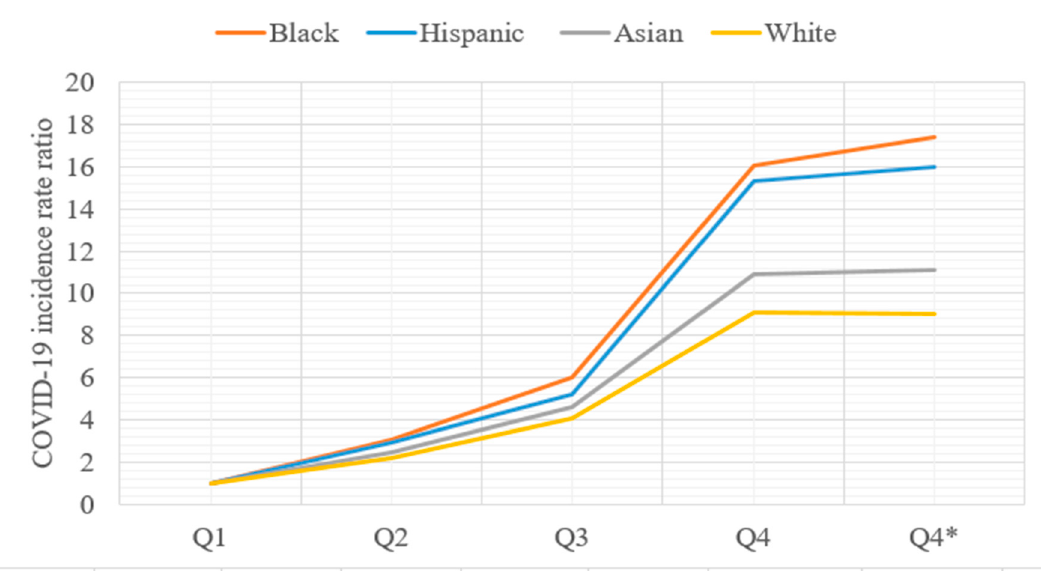
Figure 2. Variation of COVID-19 incidence rate across racial population in city/town, M.A. The COVID-19 incidence rate ratio represents the ratio of the COVID-19 incidence rate in each quantile compared to the first quantile.